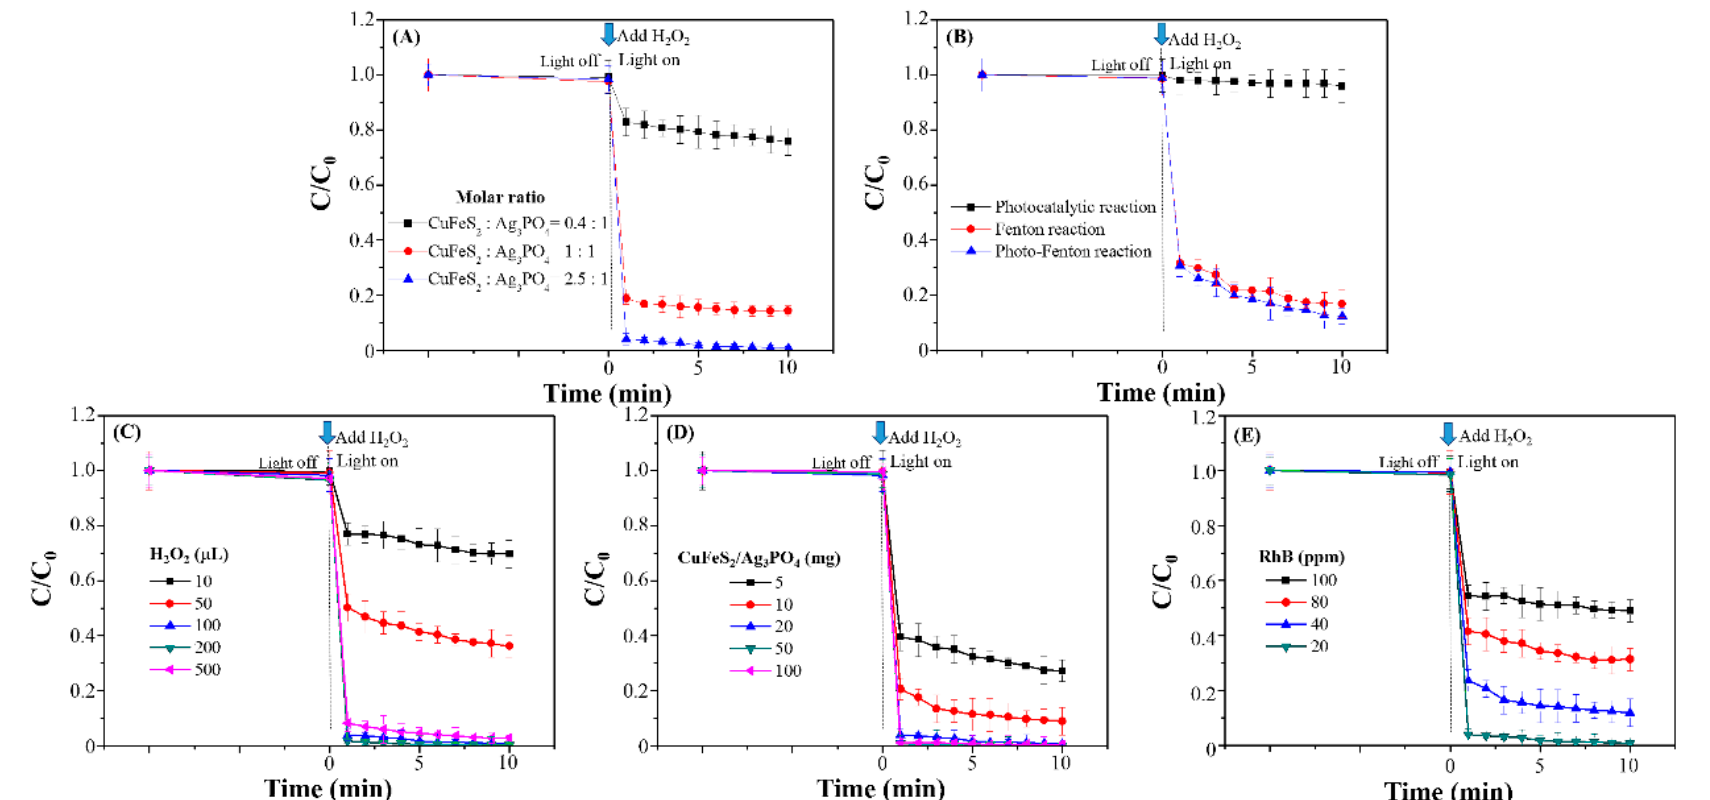
Figure 11. Degradation of RhB under di ff erent conditions: ( A ) di ff erent molar ratios of CuFeS 2 to Ag 3 PO 4 ; ( B ) di ff erent degradation procedures using the mechanical mixing of Ag 3 PO 4 and CuFeS 2 particles; ( C ) di ff erent amounts of H 2 O 2 by CuFeS 2 / Ag 3 PO 4 composites; ( D ) di ff erent amounts of CuFeS 2 / Ag 3 PO 4 composites; and ( E ) di ff erent amounts of RhB.